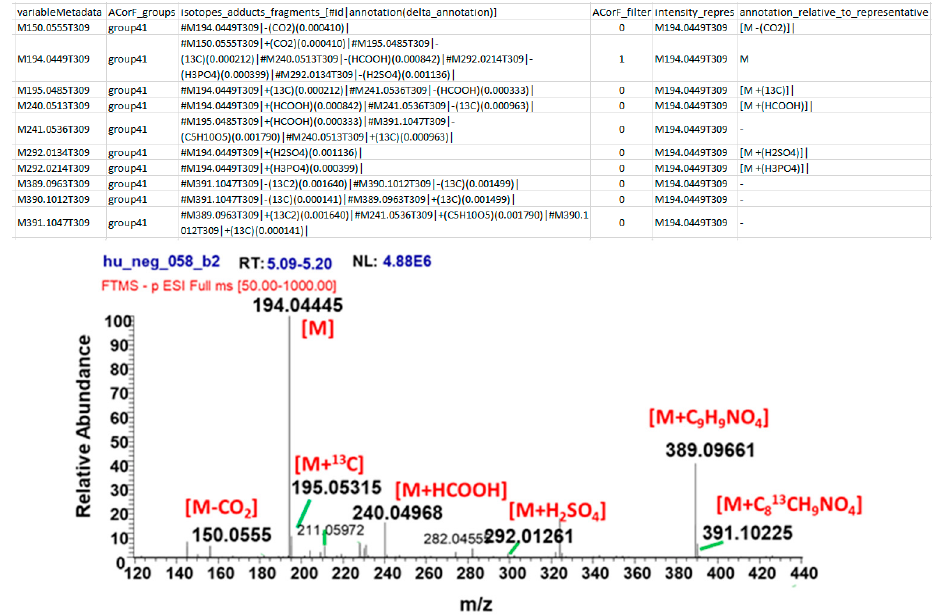
Figure 5. Example of annotation of mass difference between features using ACorF (mass threshold 0.002 Da) and the comparison of an expert annotated raw spectrum.